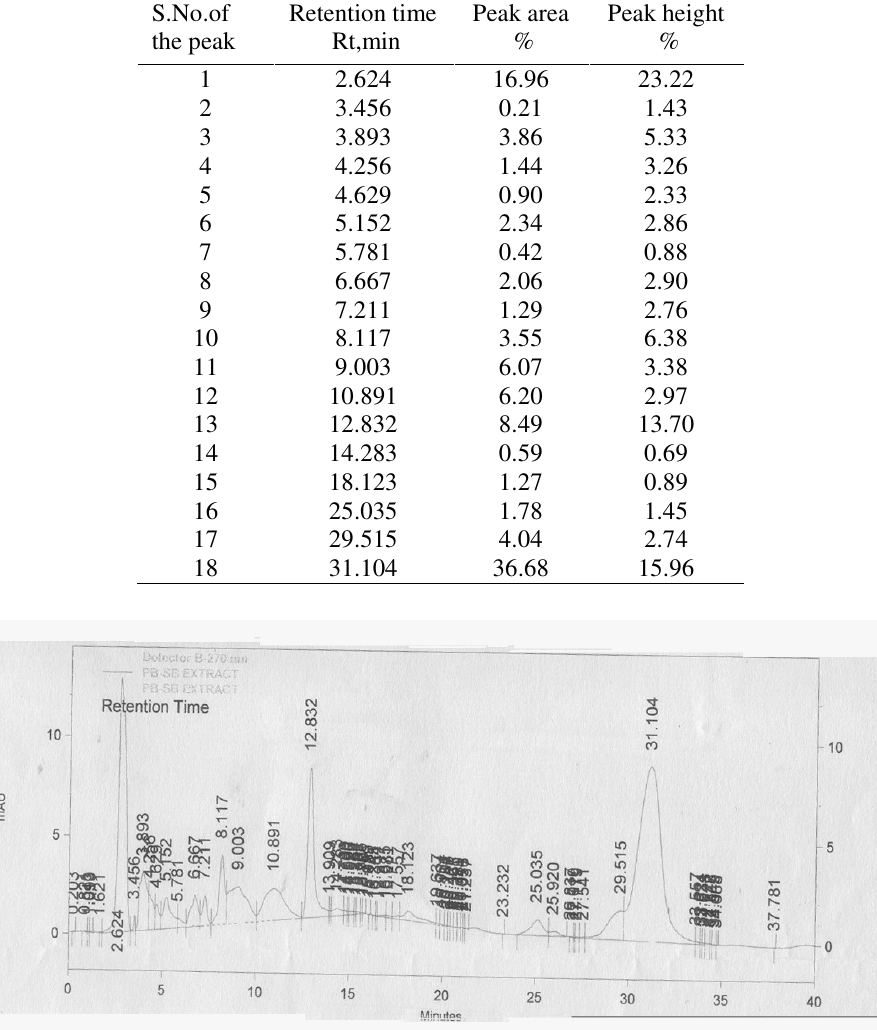
Figure 1 .HPLC alkaloid profile of Strychnos potatorum